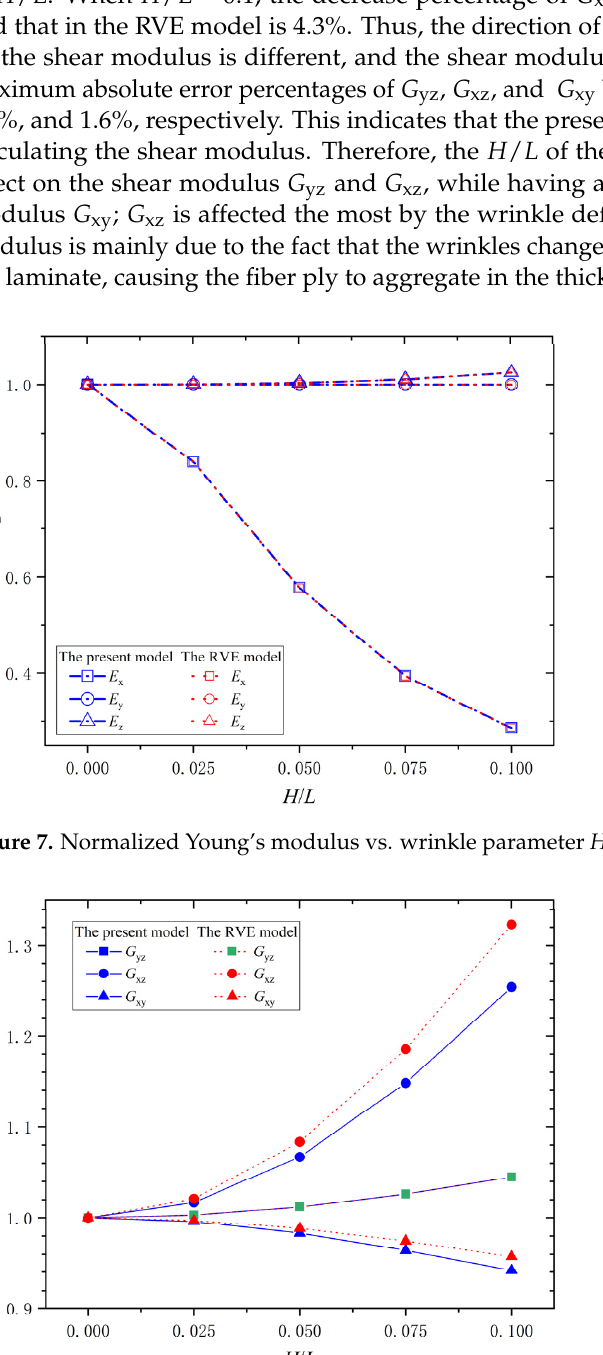
Figure 8. Normalized shear modulus vs. ply wrinkle parameter 𝐻 / 𝐿; 𝜑 = 0°. To validate the applicability of the present model with different in-plane angles, 𝜑 , the Young’s modulus of the lamina with different 𝐻/𝐿 values was studied. The situation of the normalized Young’s modulus at 𝜑 = 30° and 𝜑 = 45° were taken as an example. The relationship between the normalized Young’s modulus ( 𝐸 (cid:2934) , 𝐸 (cid:2935) , 𝐸 (cid:2936) ) and 𝐻/𝐿 of the ply with a wrinkle at 𝜑 = 30° is shown in Figure 9. The normalized Young’s modulus 𝐸 (cid:2934) de- creases with the increase of 𝐻/𝐿 . When 𝐻/𝐿 = 0.1, the percentage decrease is 37.8%. The value of normalized Young’s modulus 𝐸 (cid:2935) is always 1.0, and it doesn’t change with 𝐻/𝐿 . The normalized Young’s modulus 𝐸 (cid:2936) increases with the increase of 𝐻/𝐿 . When 𝐻/𝐿 = 0.1, the increase percentage is 2.0%. The maximum errors of the Young’s modulus ( 𝐸 (cid:2934) , 𝐸 (cid:2935) , 𝐸 (cid:2936) ) between the present model and the RVE model are 10.9%, 0%, and 2.5%, re- spectively. The relationship between the normalized Young’s modulus ( 𝐸 (cid:2934) , 𝐸 (cid:2935) , 𝐸 (cid:2936) ) and 𝐻/𝐿 of the ply with a wrinkle at 𝜑 = 45° is shown in Figure 10. The normalized Young’s modulus 𝐸 (cid:2934) decreases with the increase of 𝐻/𝐿 . When 𝐻/𝐿 = 0.1, the percentage de- crease is 19.4%. The value of the normalized Young’s modulus 𝐸 (cid:2935) is always 1.0, and it doesn’t change with 𝐻/𝐿 . The normalized Young’s modulus 𝐸 (cid:2936) increases with the in- crease of 𝐻/𝐿 , and when 𝐻/𝐿 = 0.1, the percentage increase is 1.4%. The maximum errors of the Young’s modulus ( 𝐸 (cid:2934) , 𝐸 (cid:2935) , 𝐸 (cid:2936) ) between the present model and the RVE model are 0.77%, 0%, and 5.49%, respectively. Therefore, the variation of the Young’s modulus of lamina with 𝜑 = 0°, 𝜑 = 30°, and 𝜑 = 45° are the same, and results of the present model